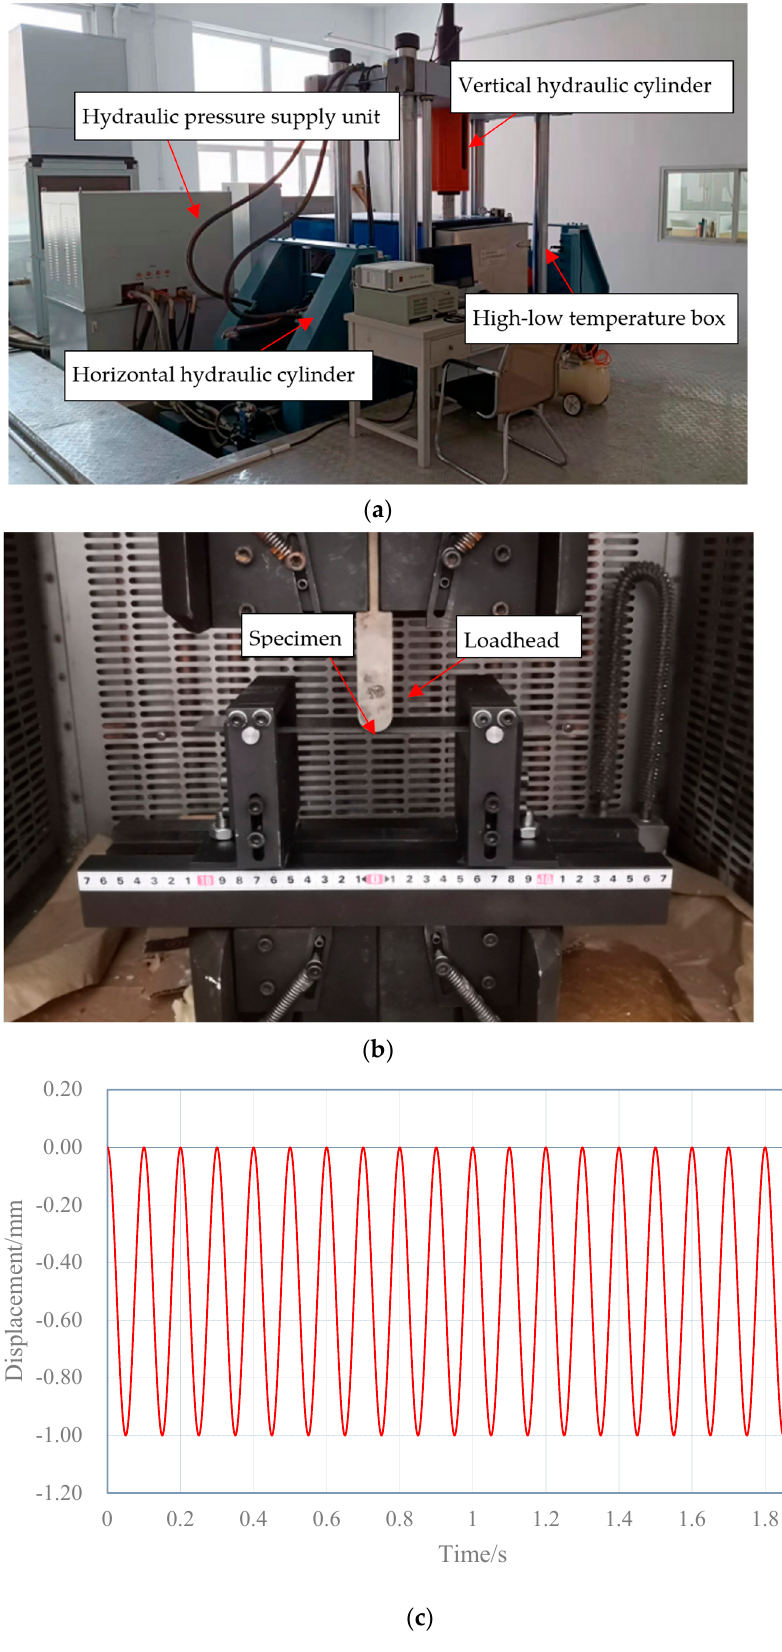
Figure 1. Test loading system and specimen installation. (a) Fatigue Test System. (b) Fixture and three-point bending specimen installation. (c) Displacement loading curve.